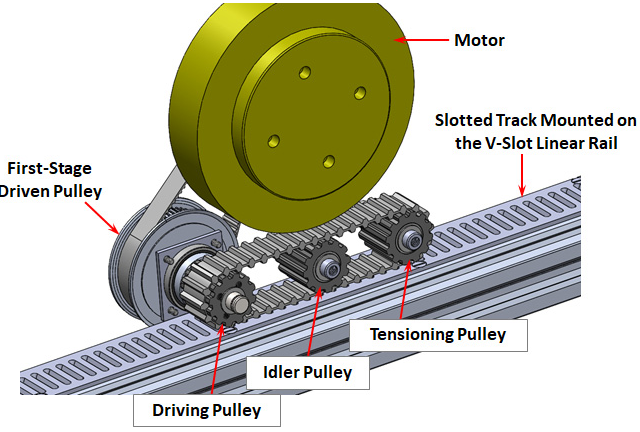
Figure 3. Design details of the B-SALD driving components (bottom view of the prototype).